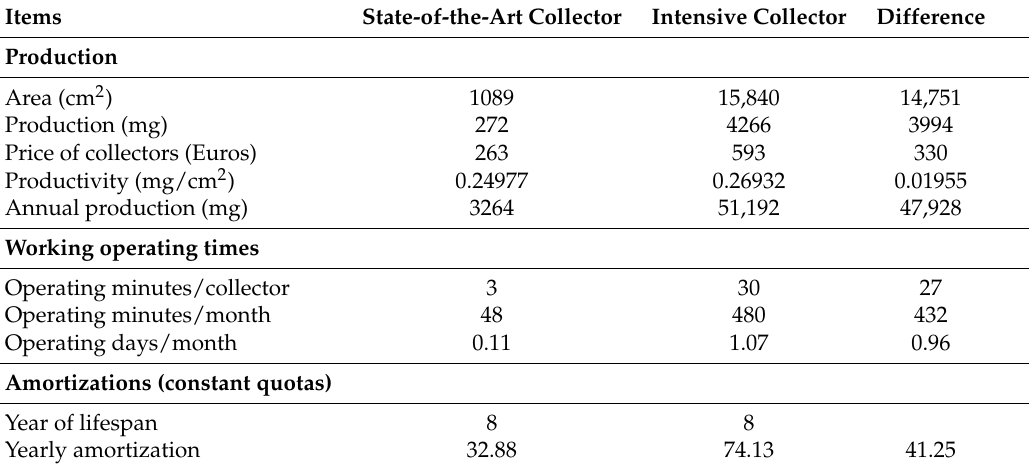
Table 5. Conditions and Results